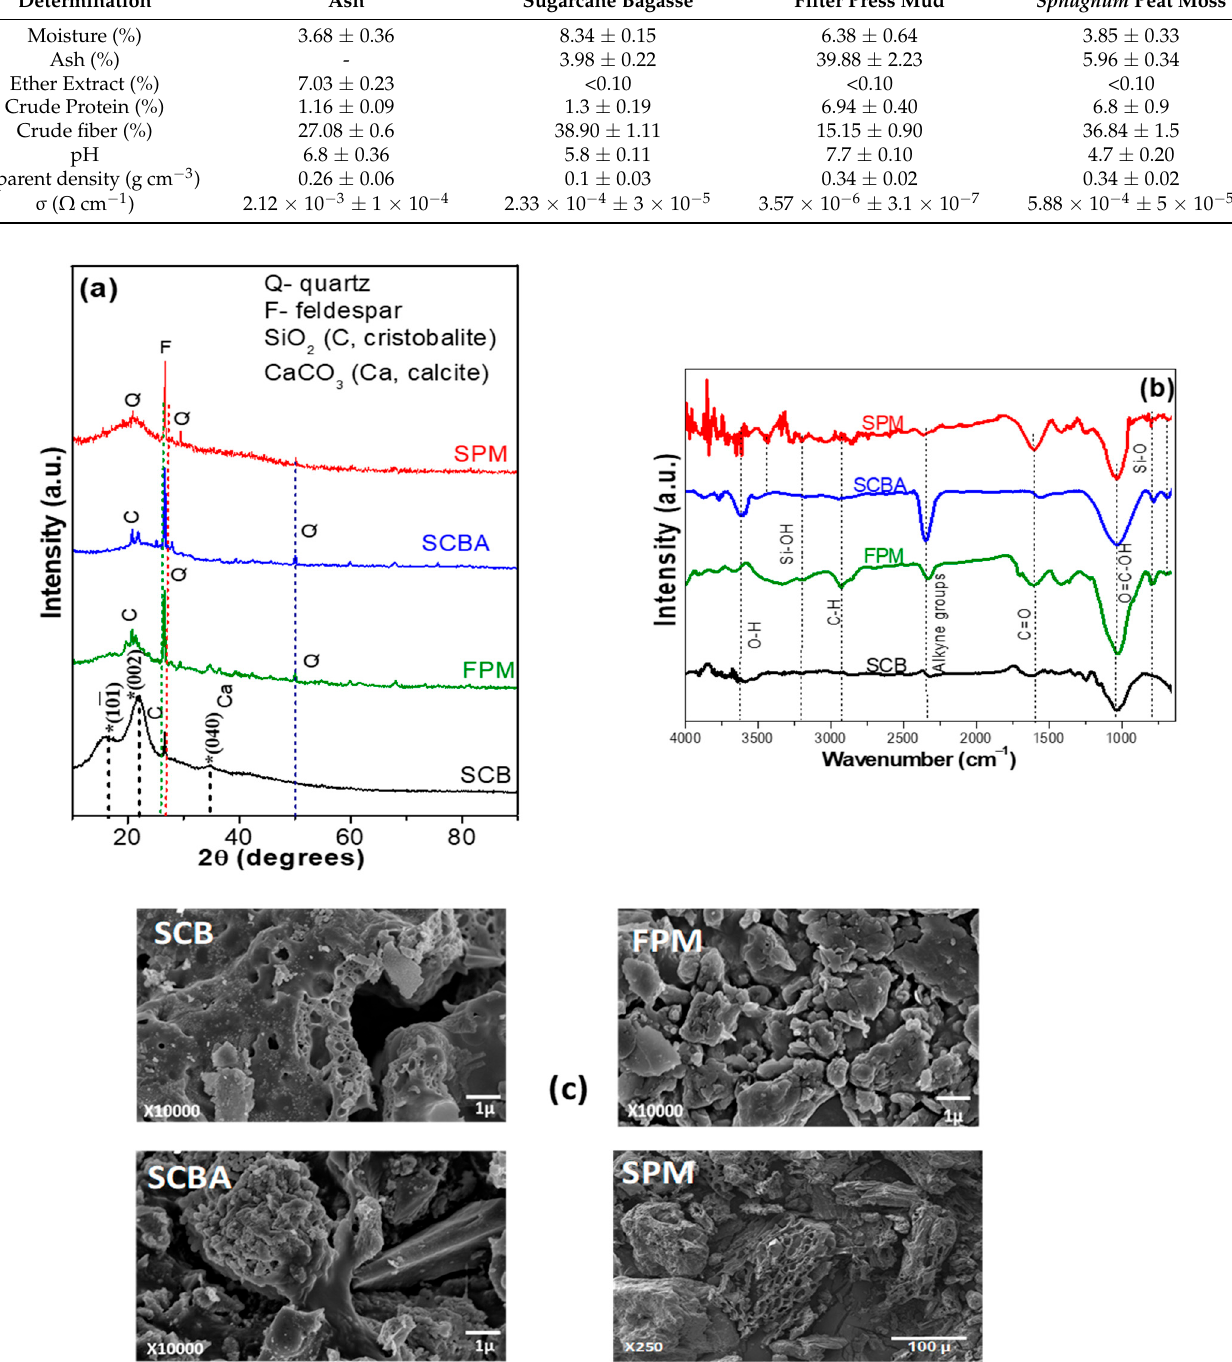
Figure 2. ( a ) X-ray diffraction patterns, ( b ) Fourier-transform infrared analysis, and ( c ) scanning electron microscopy images of SCB, FPM, SCBA, and commercial SPM before of the experimental design.